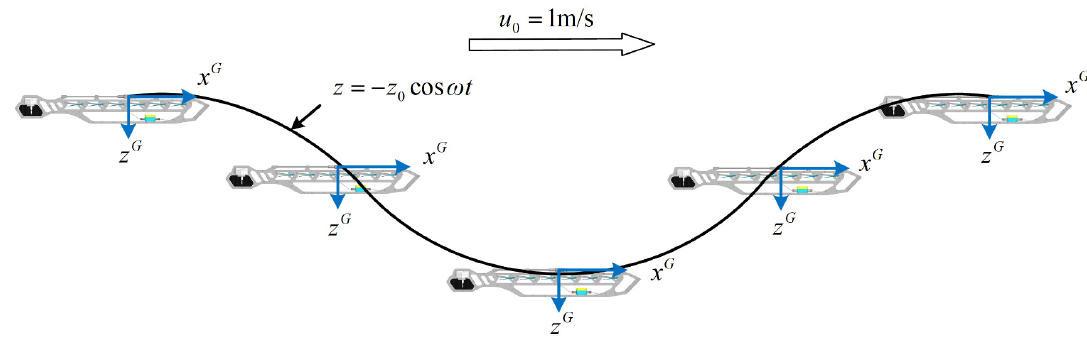
Figure 12. The schematic diagram of the pure heave test.